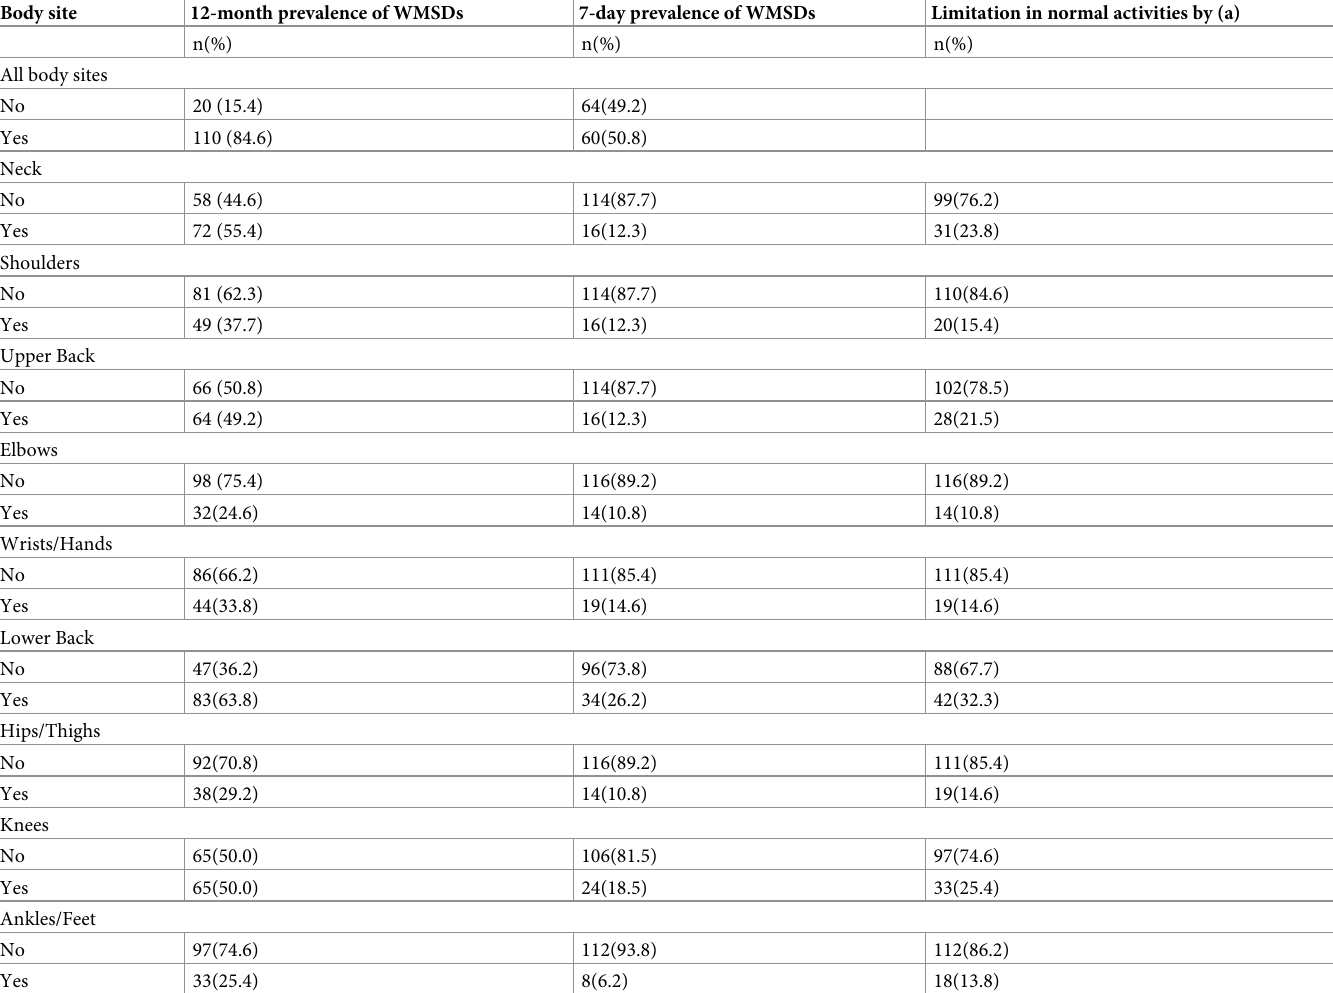
Table 3. Percentage distribution of 12-month prevalence, 7-day prevalence and limitation in normal activities caused by 12-month prevalence of WMSDs at the regions of the body in the last twelve months (N = 130).